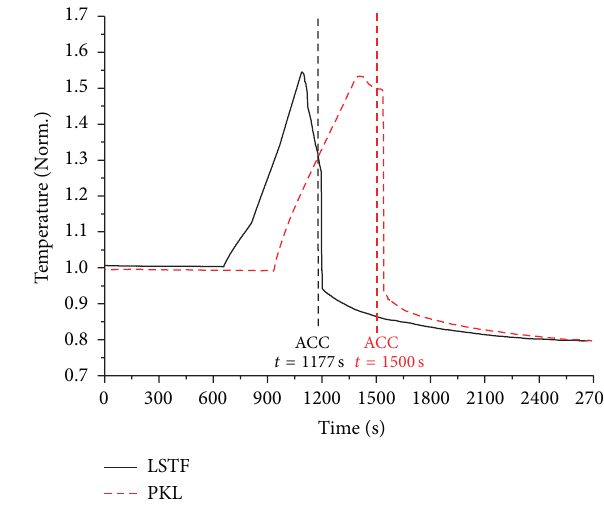
Figure 4: Core level.